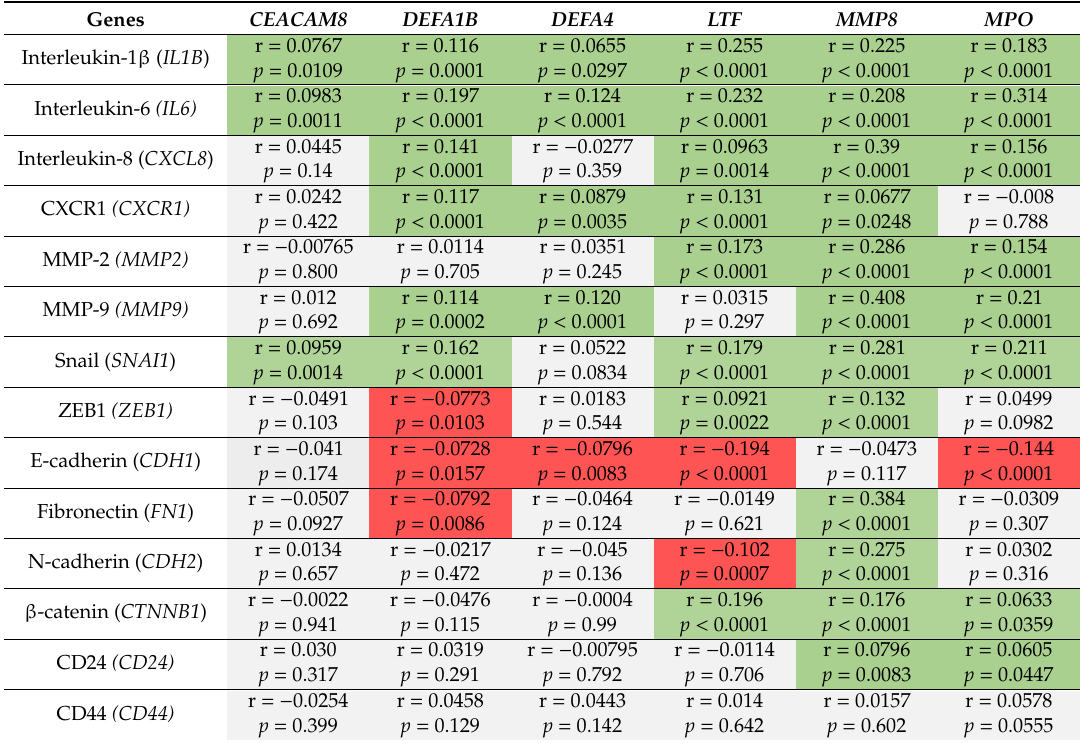
Table 1. Correlation analysis between neutrophil signature genes and pro-tumoral genes in human breast cancer samples from The Cancer Genome Atlas